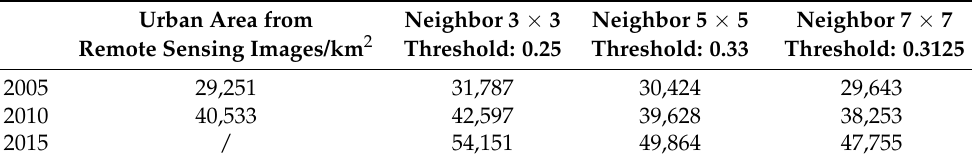
Table 4. Comparison between observed and simulated urban growth areas.